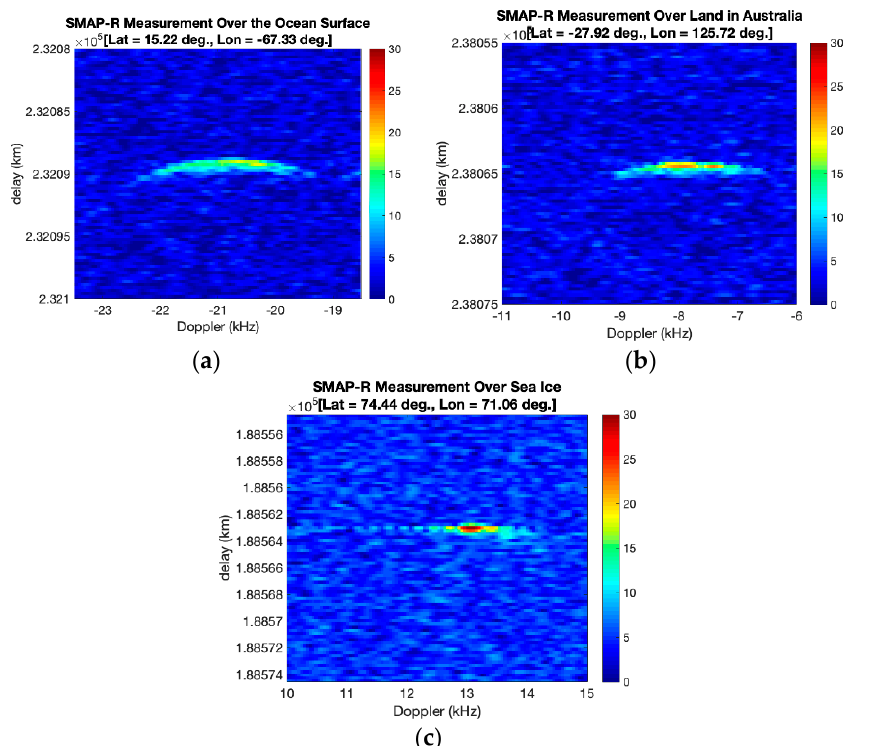
Figure 9. Delay–Doppler Maps of the scattered power measured by SMAP-R for ( a ) ocean surface in the edges of the Caribbean Sea between Puerto Rico and Caracas, ( b ) arid land surface in the middle of Australia, near the Neale Junction Nature Reserve, and ( c ) sea ice surface in the Kara Sea, Russia.